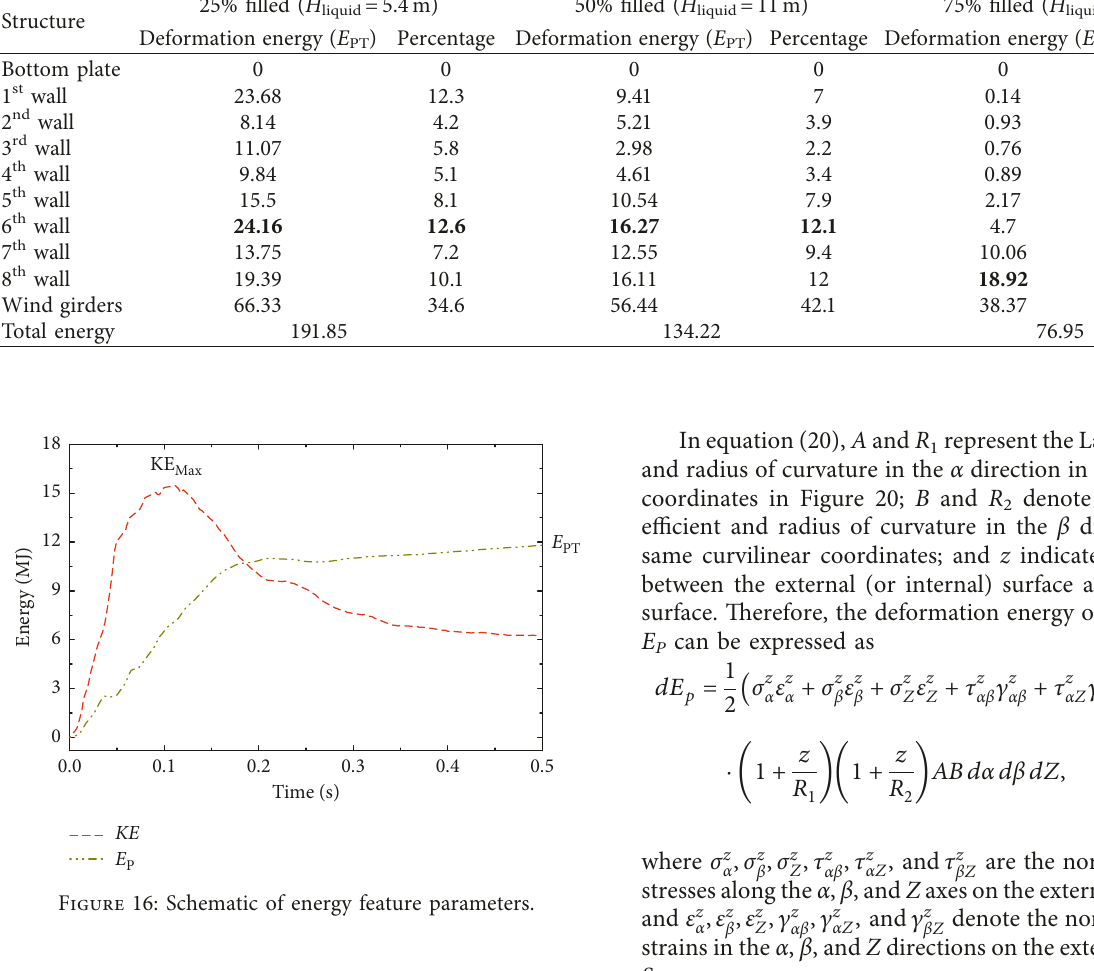
Table 6: Deformation energy of oil storage tank with fixed constraint (unit: MJ).